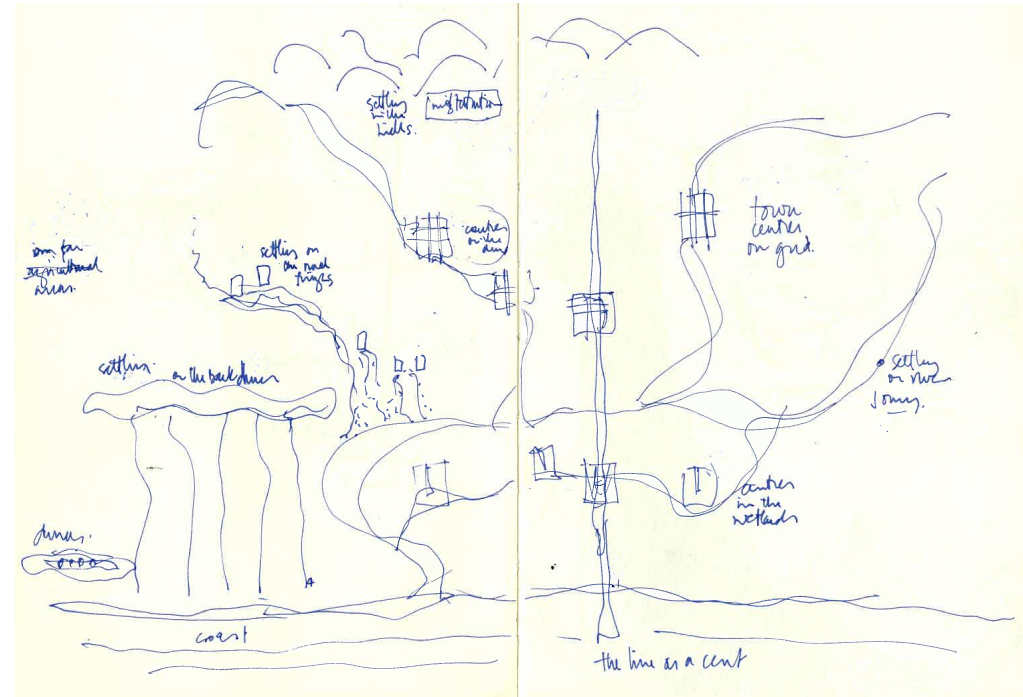
Figure 8. An ecology of projects. Less a master plan, the schemes show the potential for settlement in the sweet-spots of the region, taking advantage, through design research, of the potential to integrate competing issues and opportunities and generate an ecology of compelling alternatives. Source: Martin Bryant .